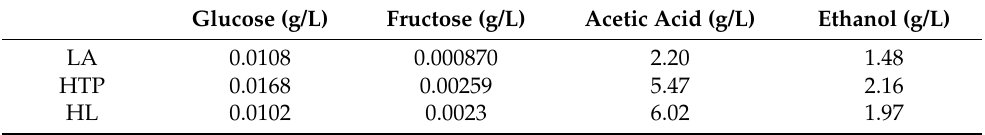
Table 4. Compositions of the filtered liquid phase of FW after (a) LA, (b) HTP, and (c) HL